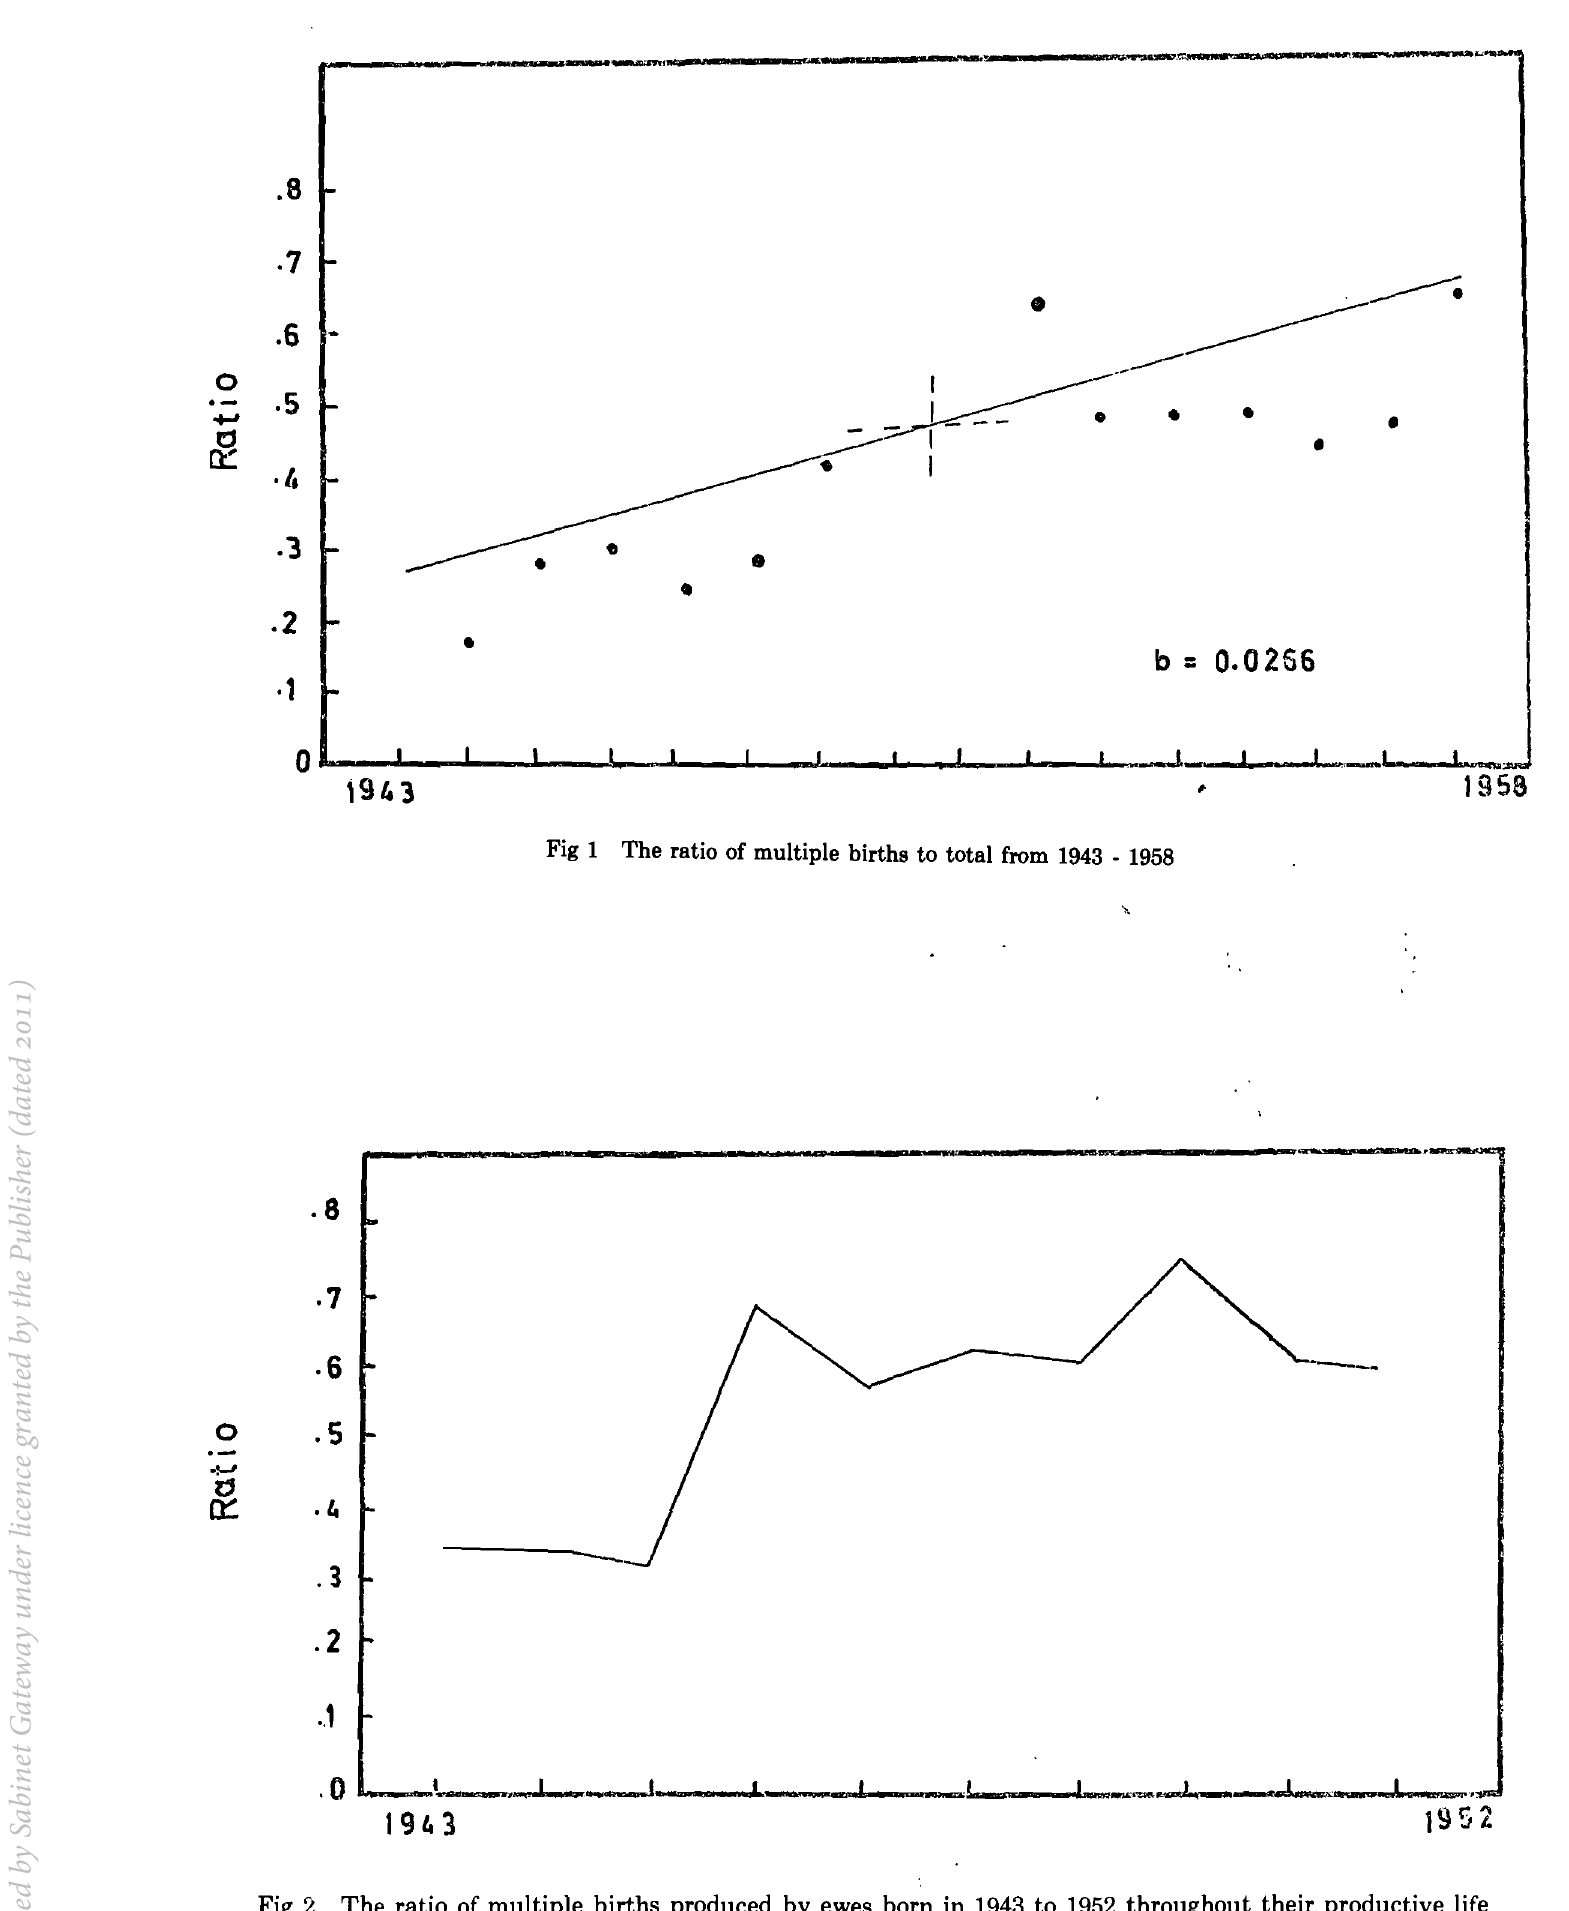
Fig 2 The ratio of multiple births produced by ewes born in 1943 to 1952 throughout their productive life